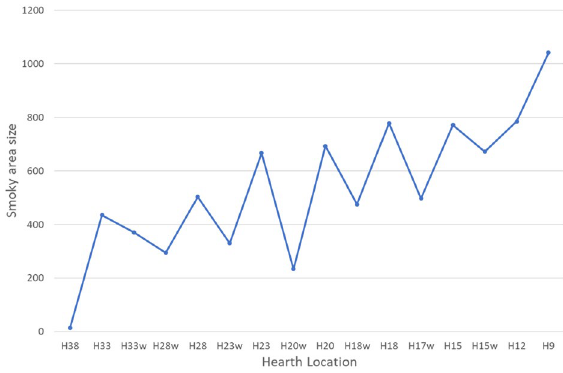
Figure 9. Comparison of red zone size for the various hearth locations.